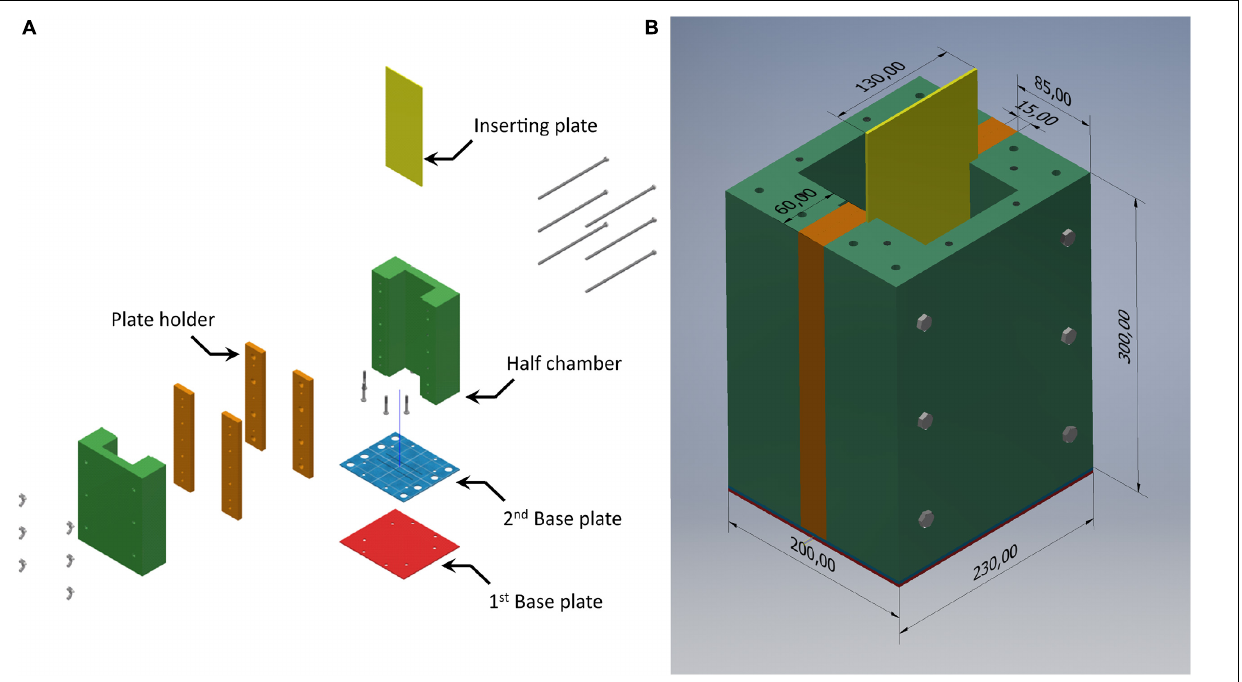
FIGURE 2 | (A) Assembly diagram of the SPI-PUSH. Both half chambers (green) and the plate holder (orange) can be joined to form one chamber. Both base plates and gaskets (not shown) seal the bottom of the chamber. The half chamber (green) and the plate holder (orange) create a groove to insert the bevelled plate (3 mm) (yellow) (B) SPI-PUSH assembled. Dimensions shown are in